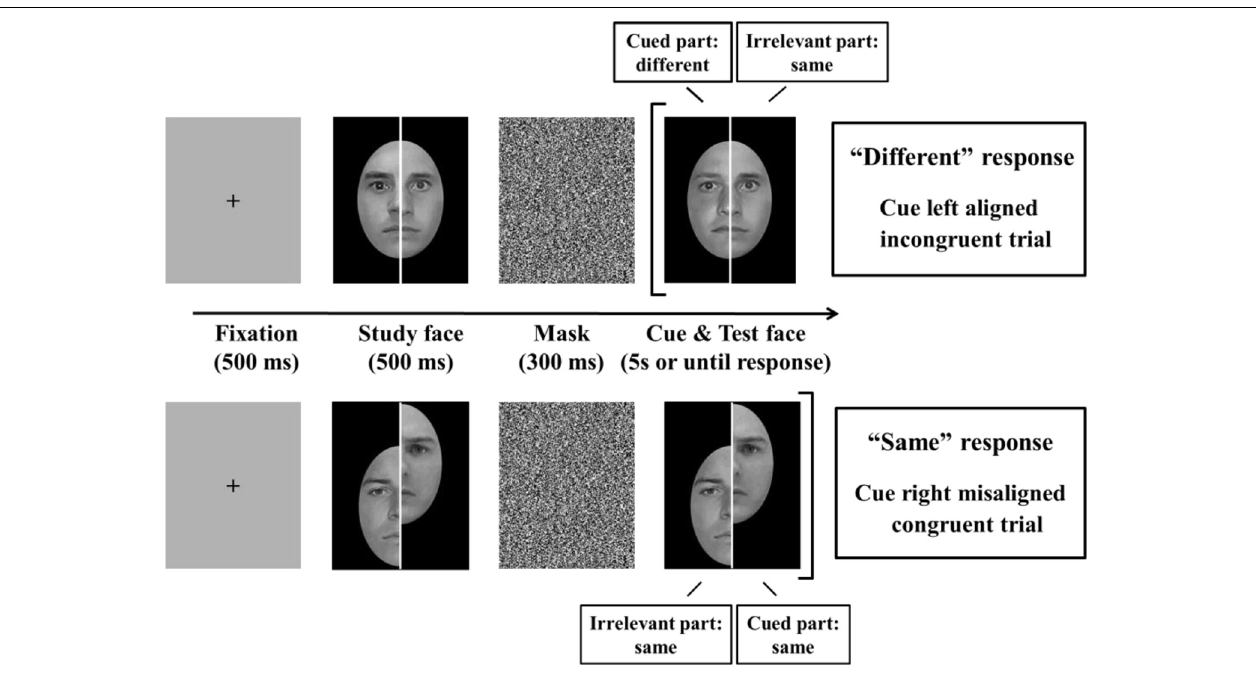
FIGURE 2 | Two sample trials of the vertical composite task. As depicted here, a trial proceeds from fixation (left of image) to response (right of image). Participants were shown a composite face (study), which was masked, and